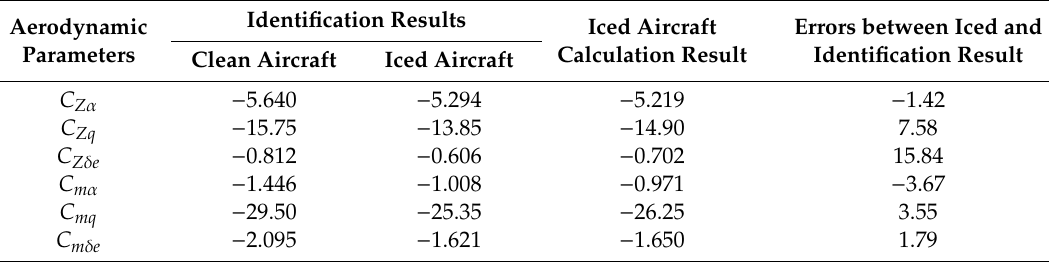
Table 10. Comparison of di ff erent kinds of